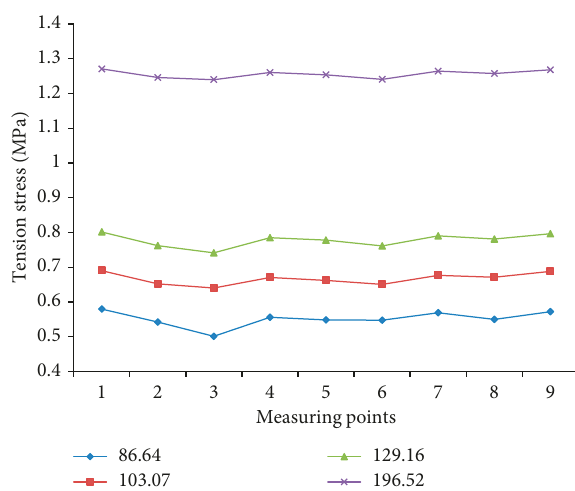
Figure 7: Tension stress value of each measuring point of the original surface